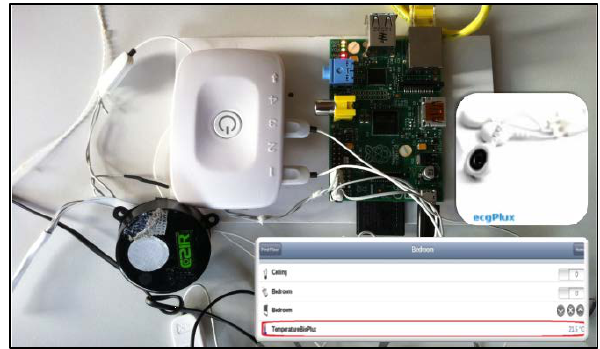
Figure 9. Experimental setup consists of several sensors and actuators connected to a RaspberryPI running OpenHAB. It is also presented a user interface image showing sensor values in